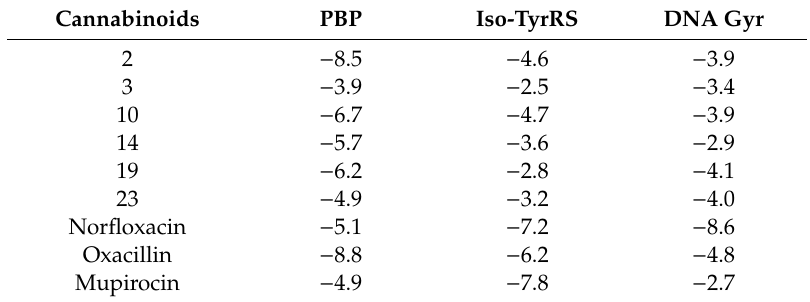
Table 5. Binding energy (kcal / mol) of selected cannabinoids for some fundamental protein targets of Staphylococcus aureus . Cannabinoids PBP